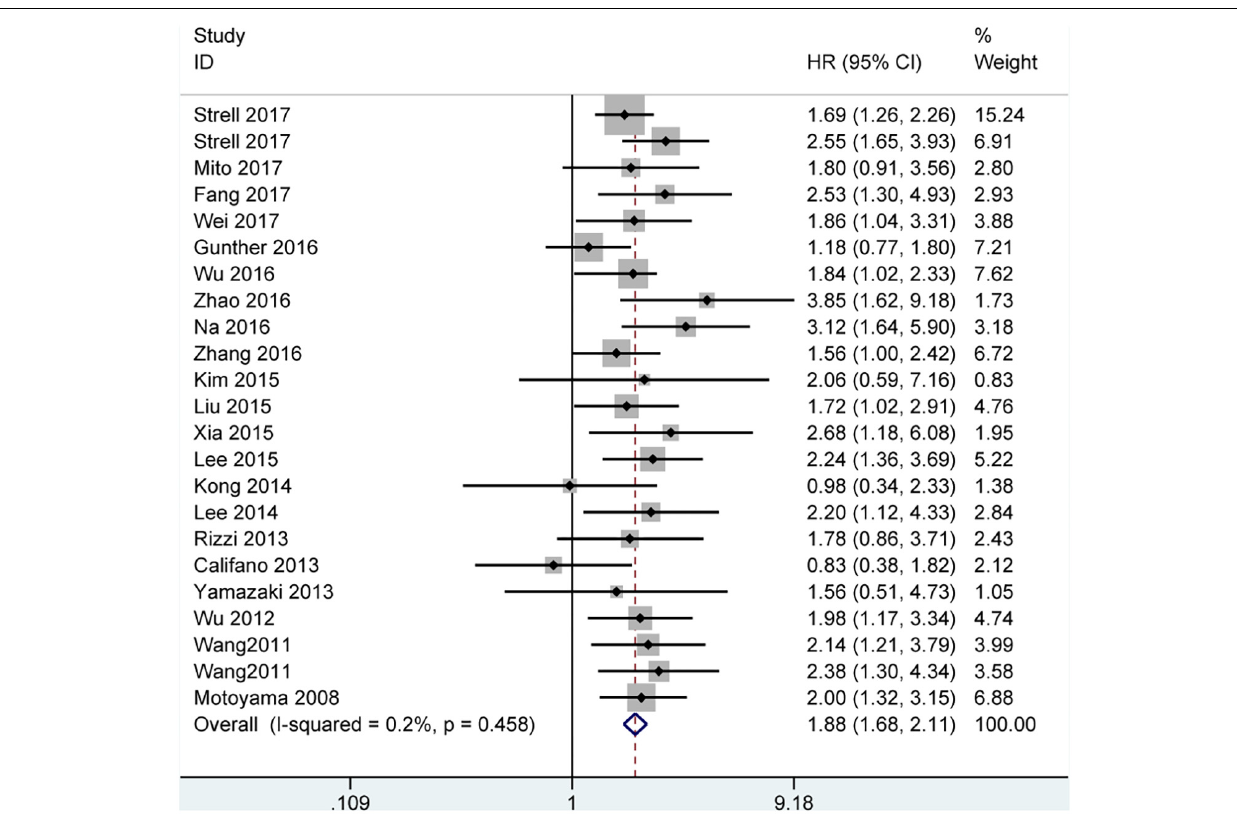
FIGURE 2 | Forest plot of studies evaluating hazard ratios of high expressed HMGA2 and the overall survival of cancer patients.